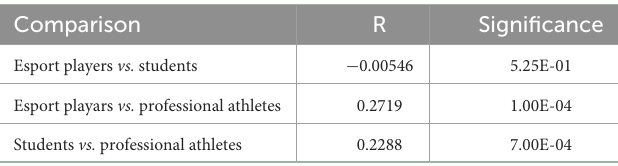
TABLE 3 Community dissimilarities, as measured by ANOSIM R (number of permutations: 9999). Comparison R